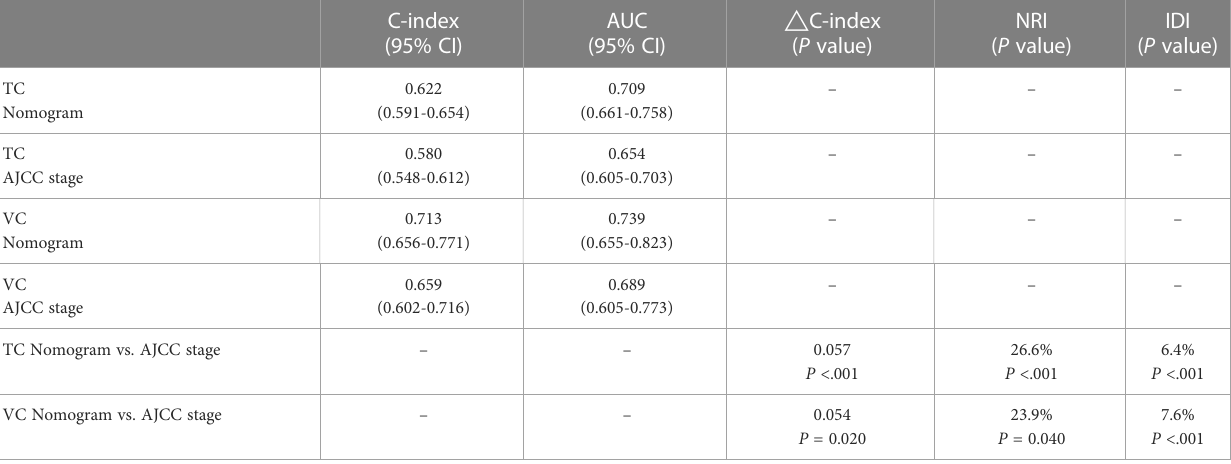
TABLE 3 The discriminatory ability of the nomogram model vs. AJCC stage.